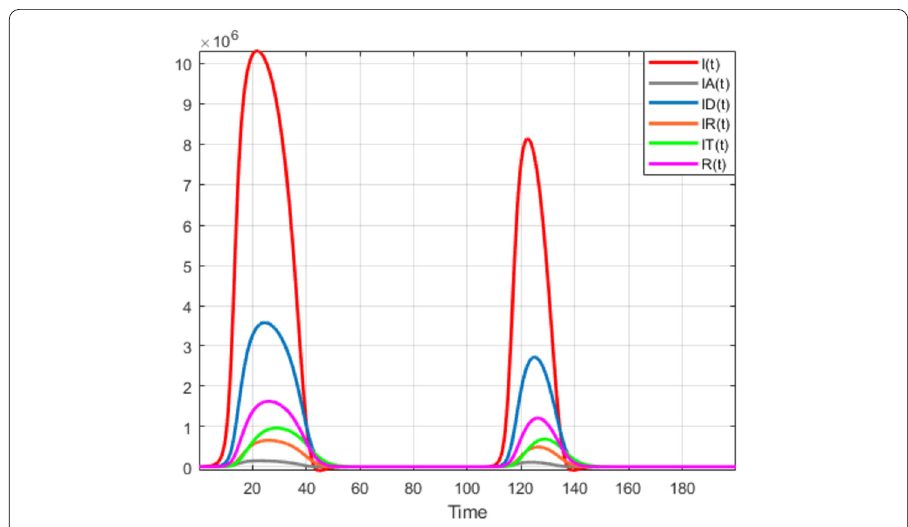
Figure 29 Numerical visualization of COVID-19 model for α = 0.76